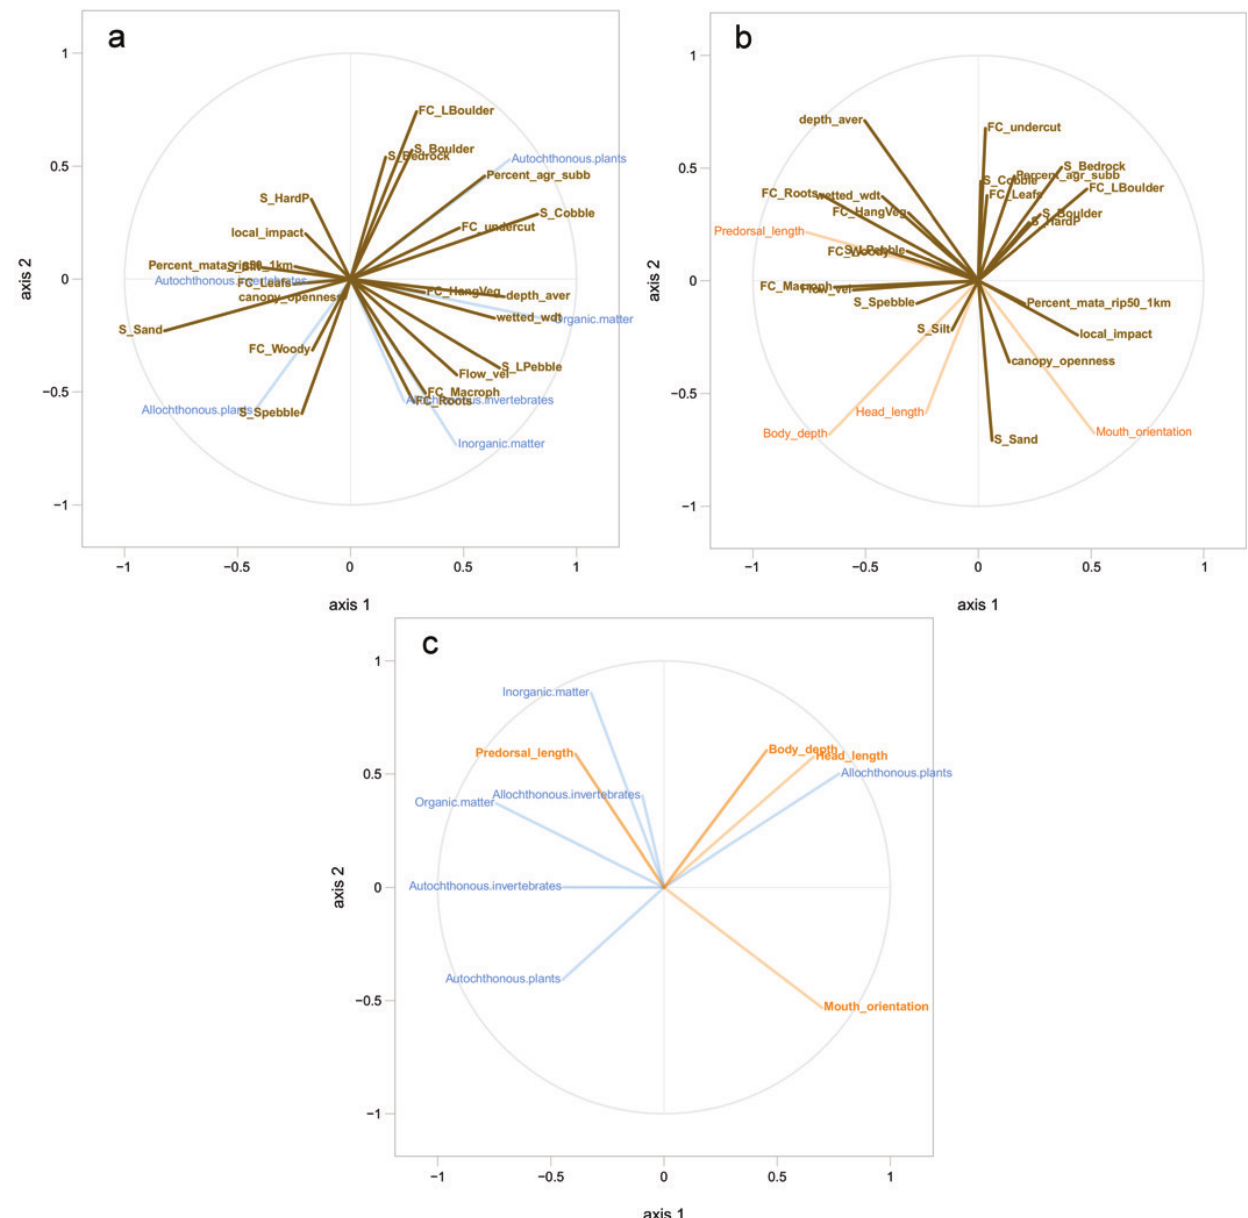
Fig. 4. Partial least squares canonical analysis depicting the covariation between: a. dietary (blue) and environmental (brown) variables; b. morphological (orange) and environmental (brown) variables; c. dietary (blue) and morphological variables (orange). Variables near the edge of the circle are better represented by the model. Variables near one another are positively correlated, whereas variables opposite one another are negatively correlated. Uncorrelated variables are orthogonal